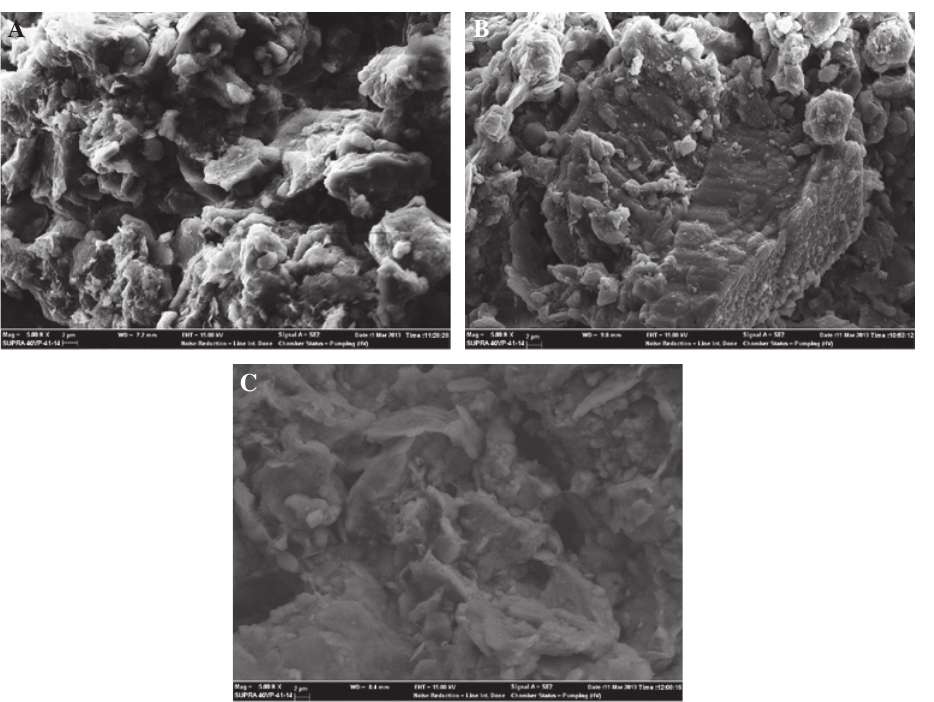
Figure 9 SEM images of artifical mixed soil samples (magnification × 5000): (A) 10% clay I, (B) 20% clay I, and (C) 40% clay I.